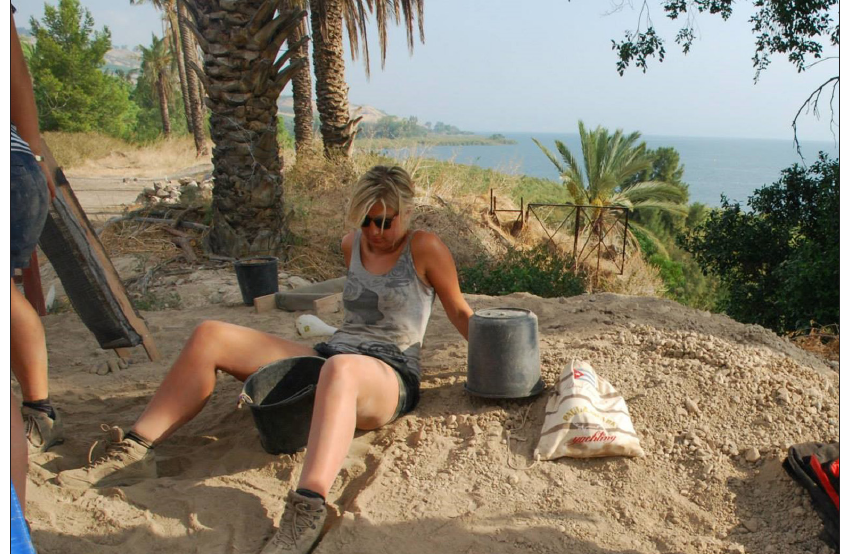
Figure 6: Roseanna Cawthorne during excavations at Tel Bet Yerah, Israel, in 2013 (Photo: Claire